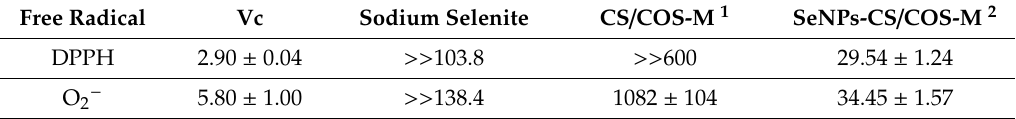
Table 3. The EC 50 of the free radical scavenging activities of the samples (mg / L, n = 3).